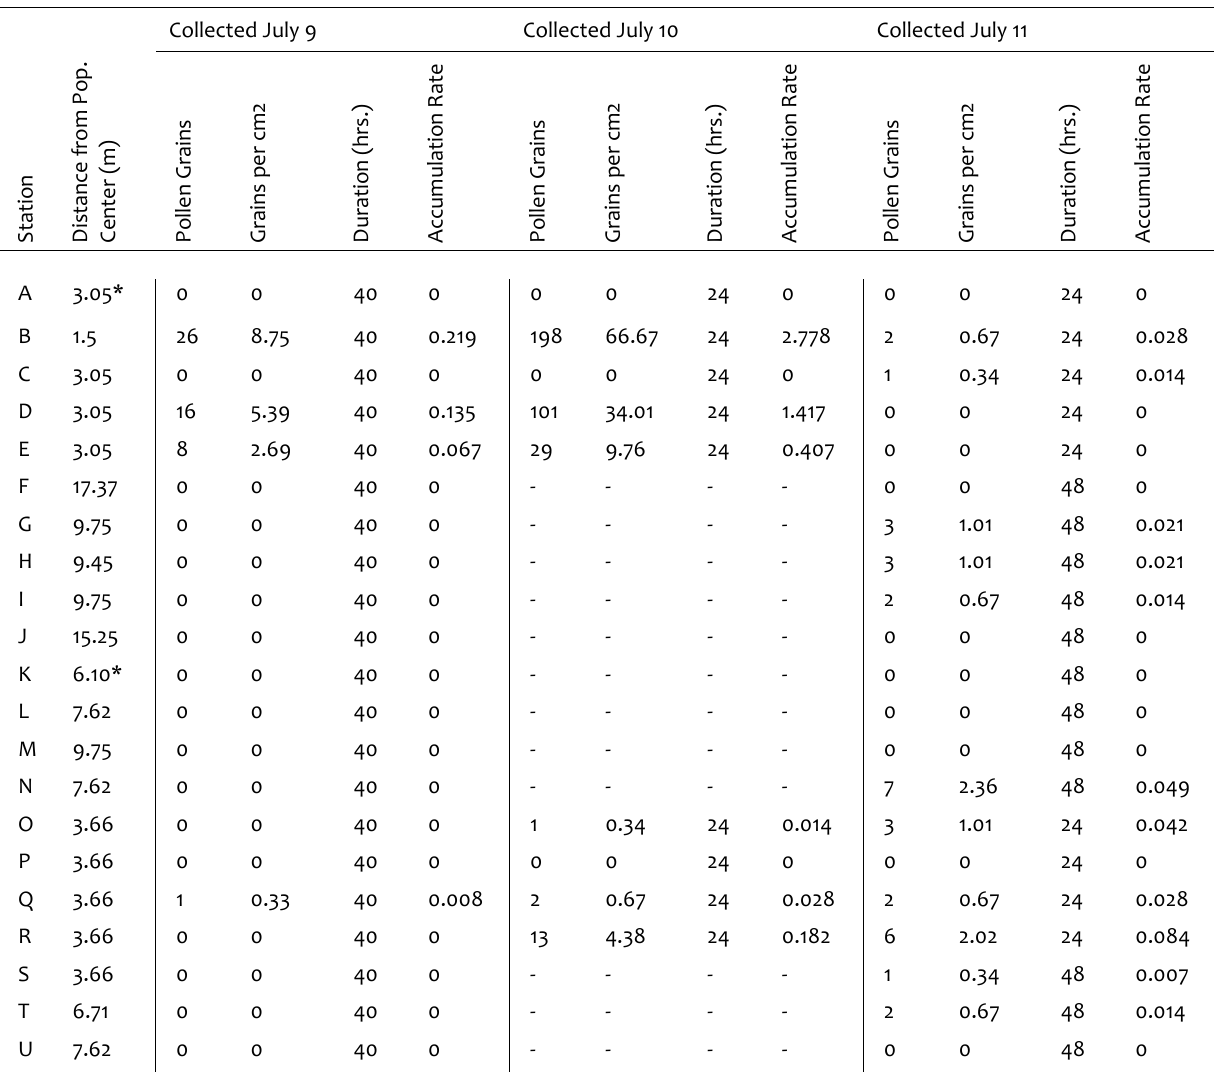
Table 1. Pollen grains of D . obovata collected by pollen traps in Pammel Woods, Ames, IA in July 2020. (Continued next